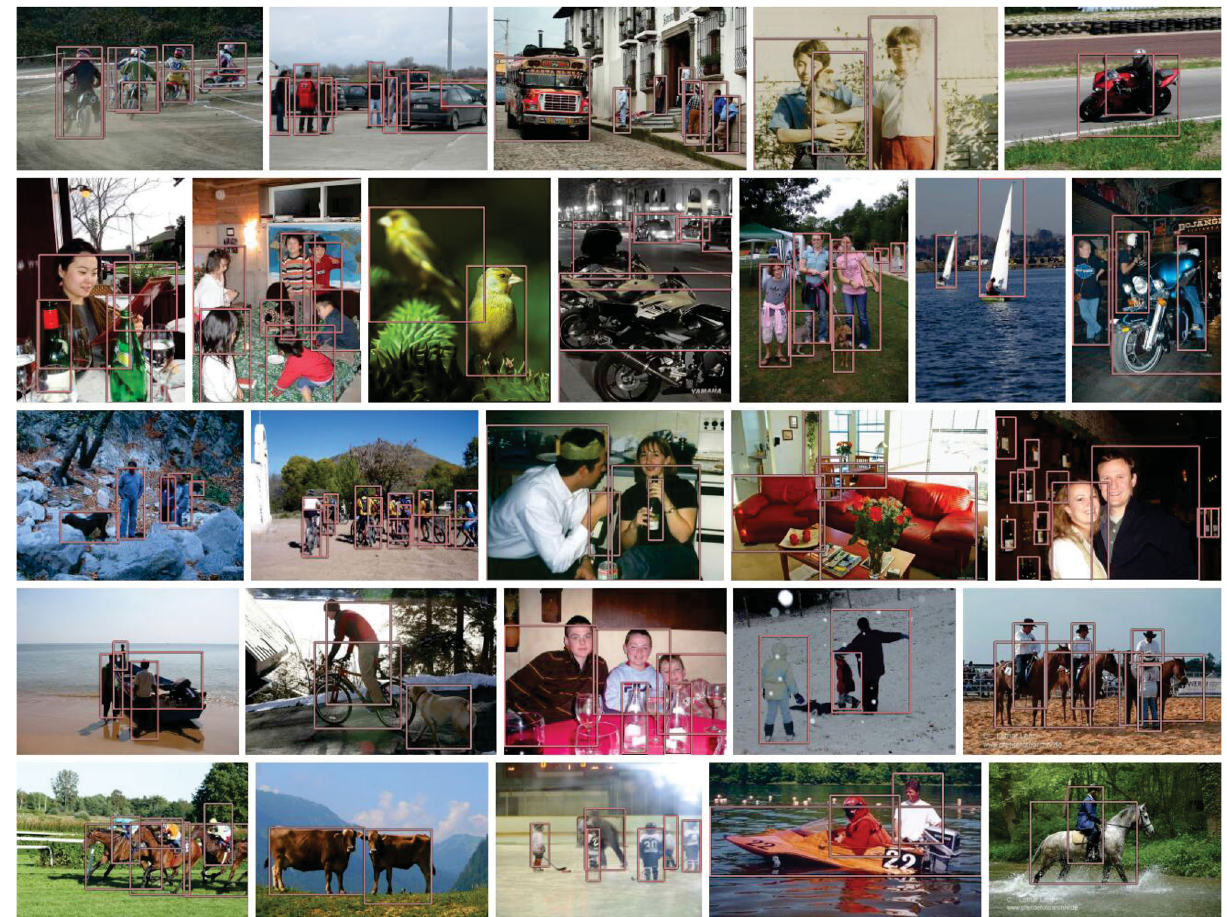
Fig. 4 True positive object proposals for VOC2007 test images using